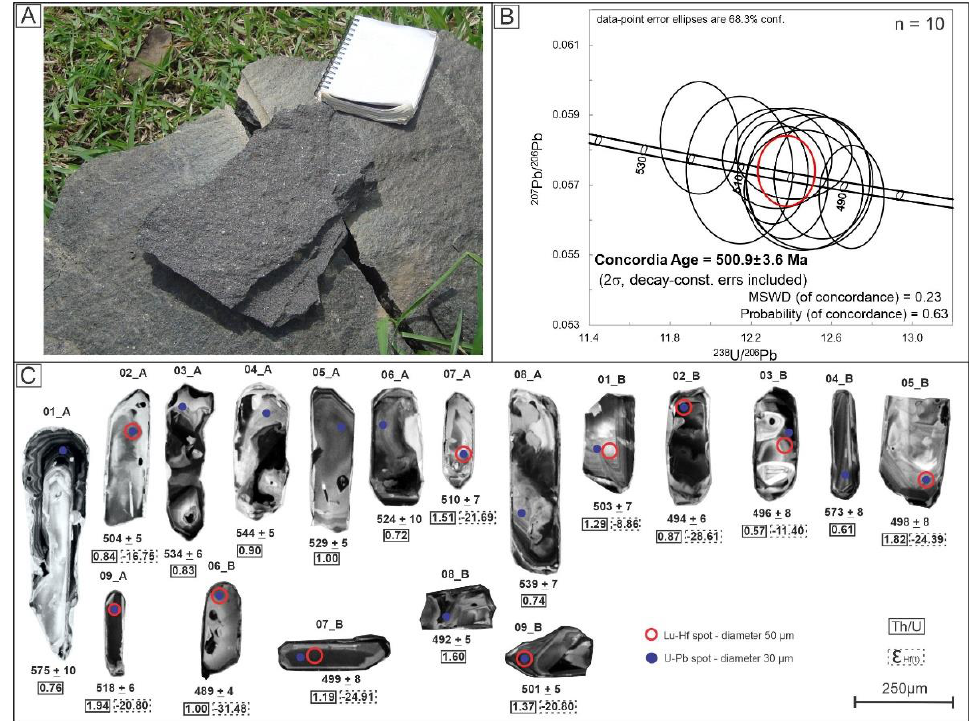
Figure 5. ( A ) A representative sample of SAIC mafic core from the point SAIC-06. ( B ) Concord age for the sample SAIC-06A. ( C ) Cathodoluminescence image of the analyzed zircon